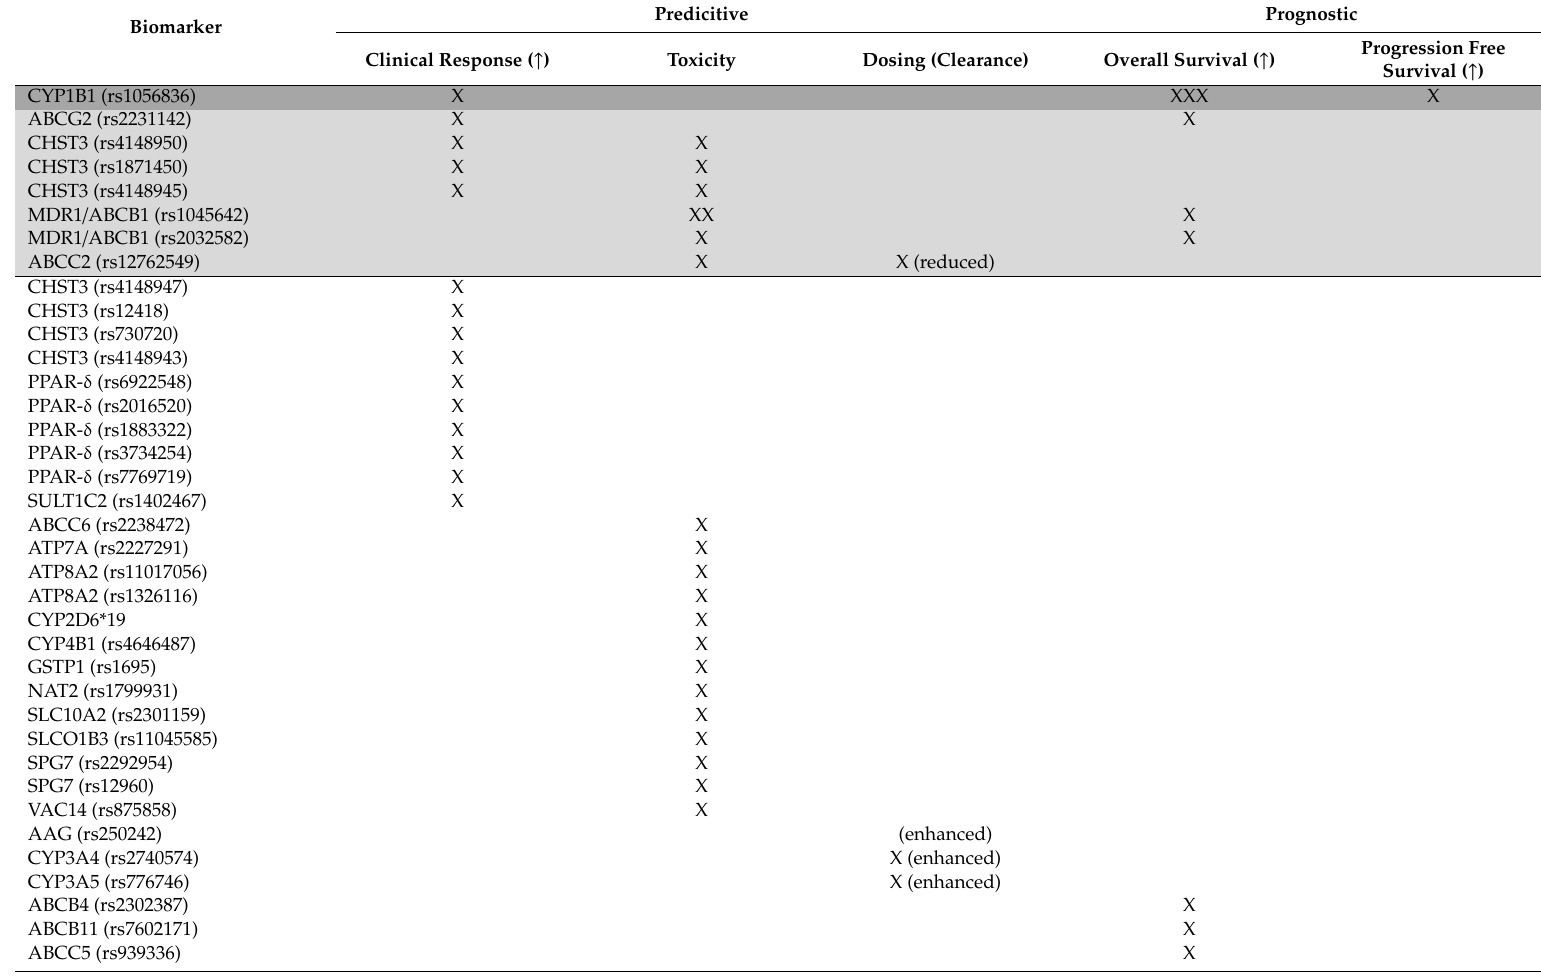
Table 5. Germline genomic biomarkers in docetaxel treatment of prostate cancer with clinical translational